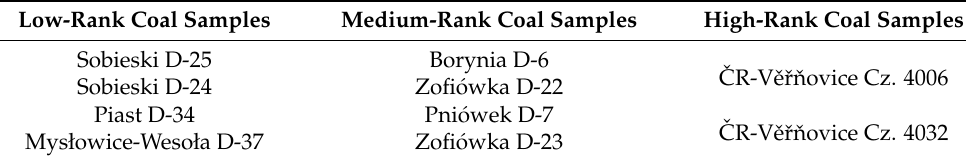
Table 1. Coal samples selected for testing, taken from the Upper Silesian Coal Basin. Low-Rank Coal